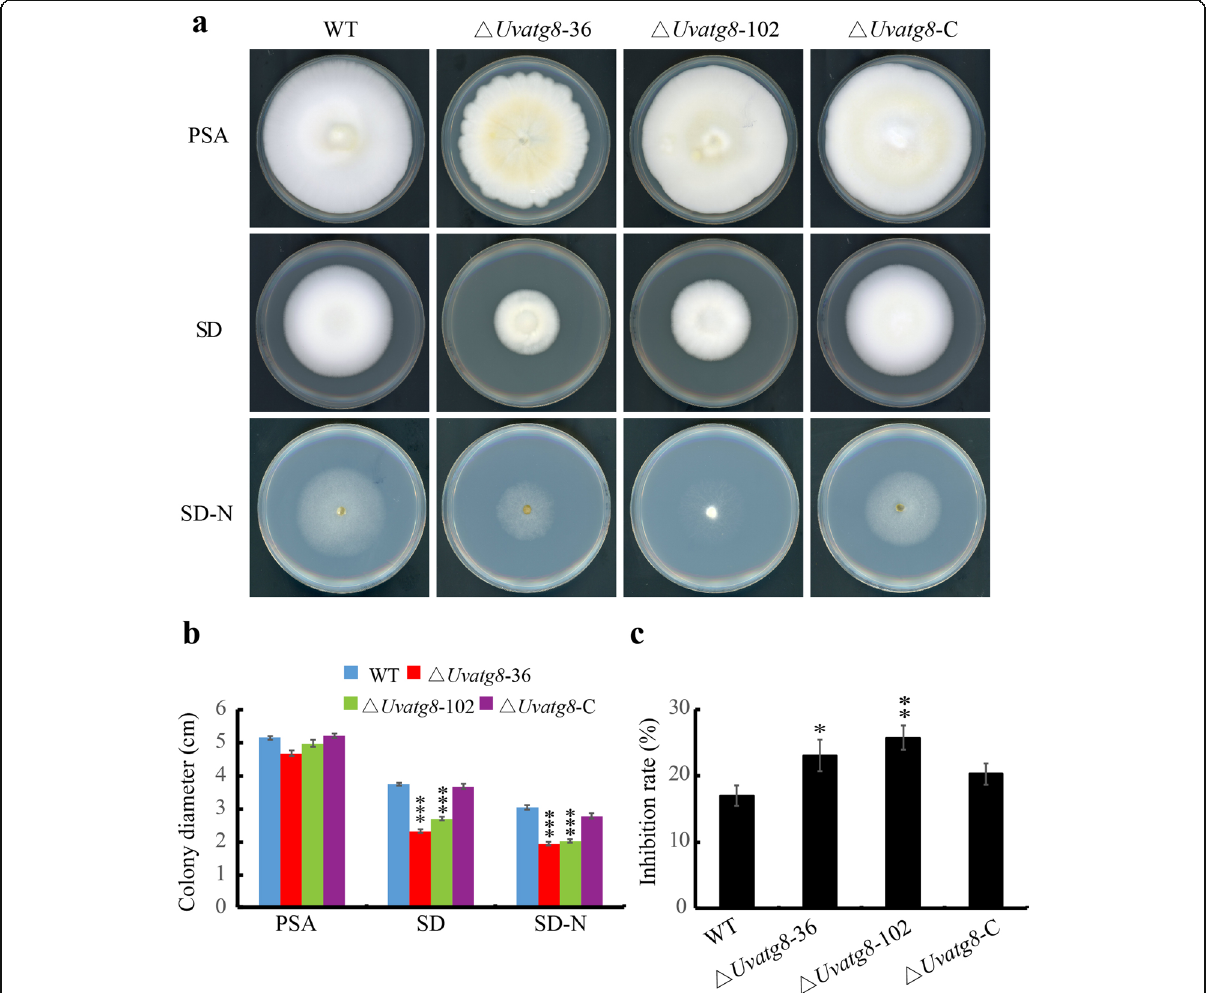
Fig. 4 UvAtg8 plays important roles in the fungal growth. a, Radial growth of Δ Uvatg8 was reduced. Colonies of the WT, Δ Uvatg8 , and Δ Uvatg8 -C strains were grown on the PSA 、 SD and SD-N medium in dark for 15 d and then imaged. b, Statistical analysis of colonies diameters of test strains on the PSA, SD and SD-N plates. c, Statistical analysis of inhibition rate of test strains under nitrogen starvation condition by comparing the fungal growth on the SD-N and SD medium. Three independent biological experiments were performed with three replicates each time. The data were subjected to Duncan ’ s Test and the significant differences were shown in the figure with asterisks (*, p < 0.01; **, p < 0.005; ***, p <